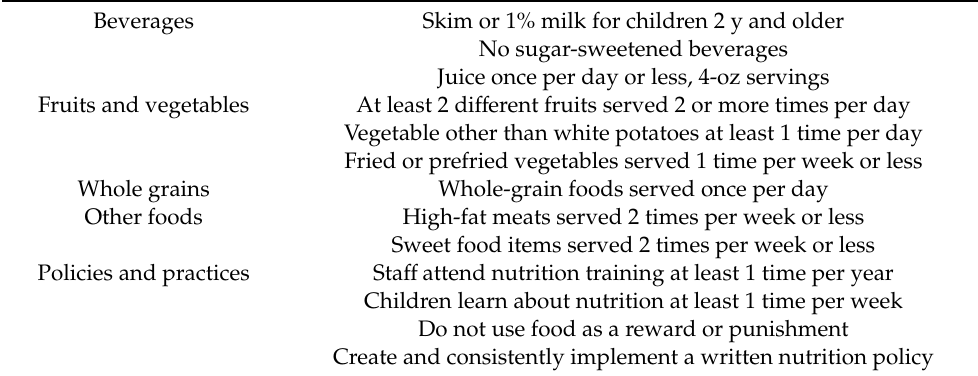
Table 1. ABC Quality Program nutrition standards